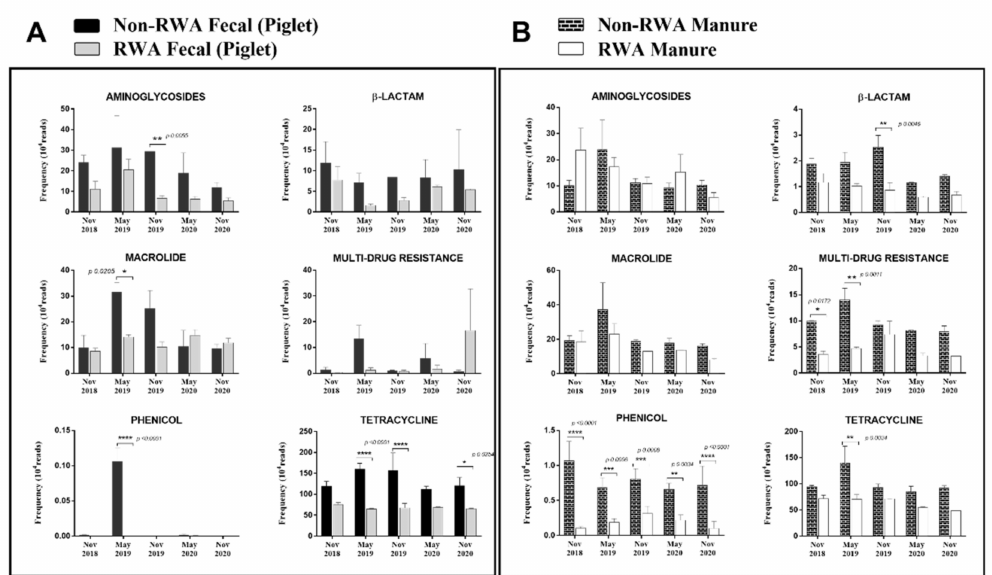
Figure 5. Comparison of non-RWA − (minus sign) and RWA + (plus sign) resistomes from piglet feces ( A ) and barn manure ( B ). The frequency of antibiotic resistance genes (ARGs) clustered into 6 classes: aminoglycosides, β -lactams, macrolides, MDR, phenicol, and